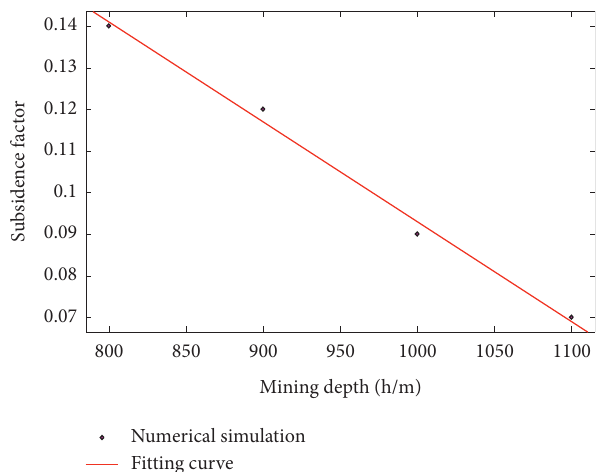
Figure 4: Relationship between the subsidence factor and the mining depth. Table 3: Numerical stimulation results in different mining width. Mining